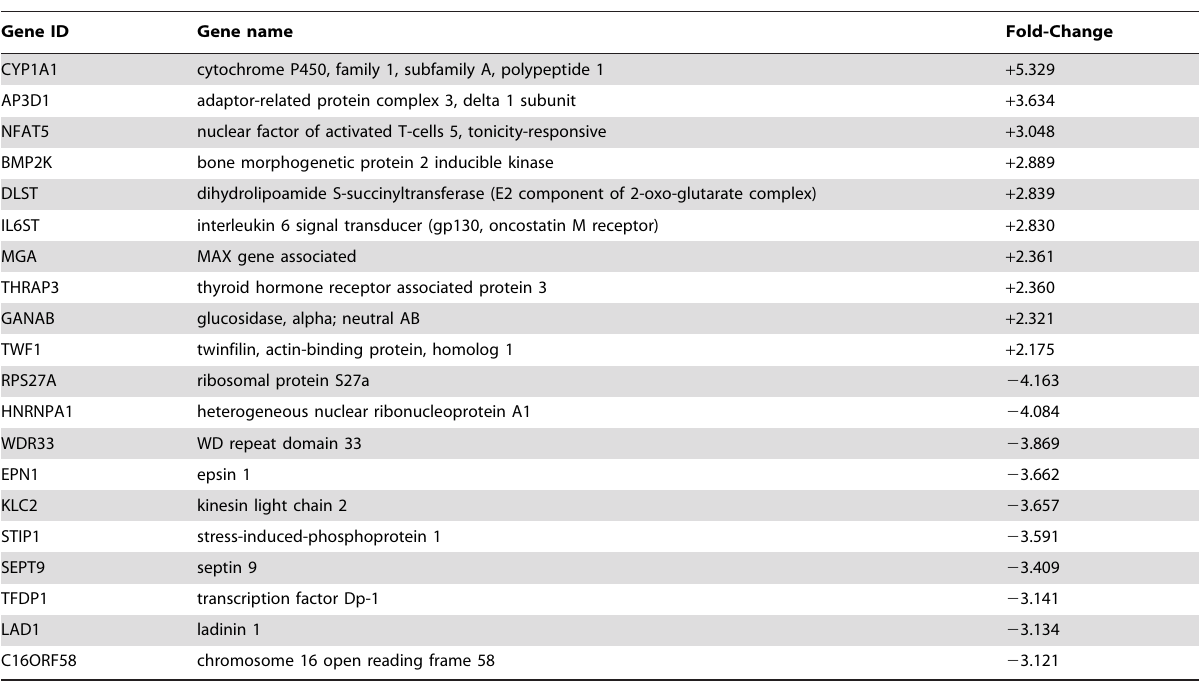
Table 3. The top ten genes modulated by AS601245.